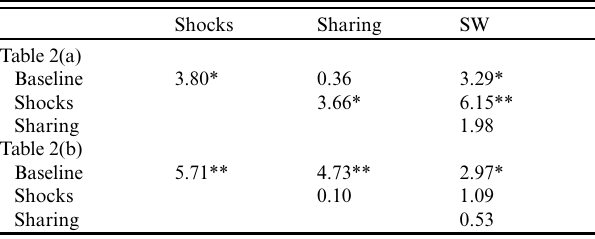
Table 2 . Significant differences in the mean fraction of harvested resources between treatments (a). Significant differences in mean resources (before exhaustion) between treatments (b). In tables, I report